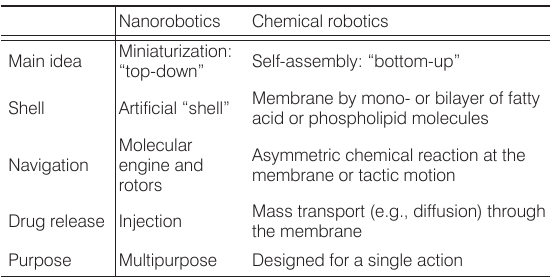
Table 1. “Nanorobotics” versus “Chemical